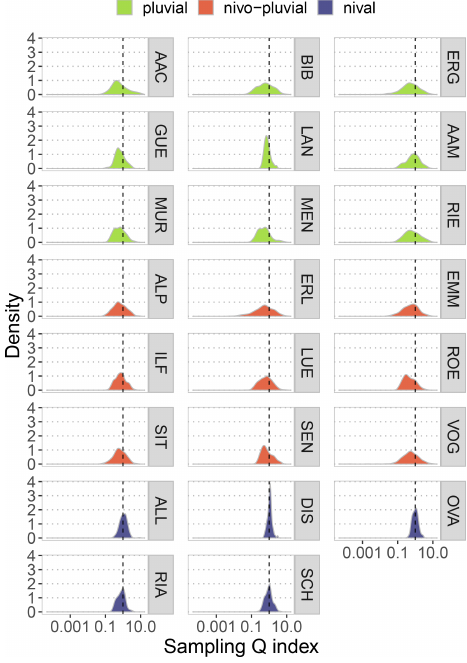
Figure 7. Sampling condition distribution expressed as the sam- pling Q index. The dashed line shows the long-term streamflow conditions of the day of sampling. Values of the index larger than 1 indicate wetter conditions than the observed long-term condition, whereas values smaller than 1 indicate conditions drier than the long-term condition on this day of the year (sum of 3 consecutive days). For the Roethenbach catchment (ROE) simulated streamflow was used. Note that the x axis is log-scaled to visualize the per- centual difference more